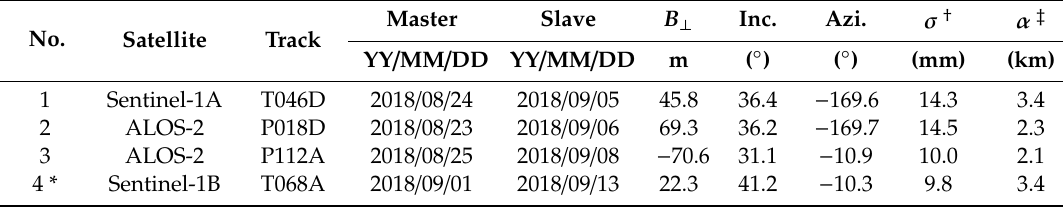
Table 2. InSAR data parameters used in this study.